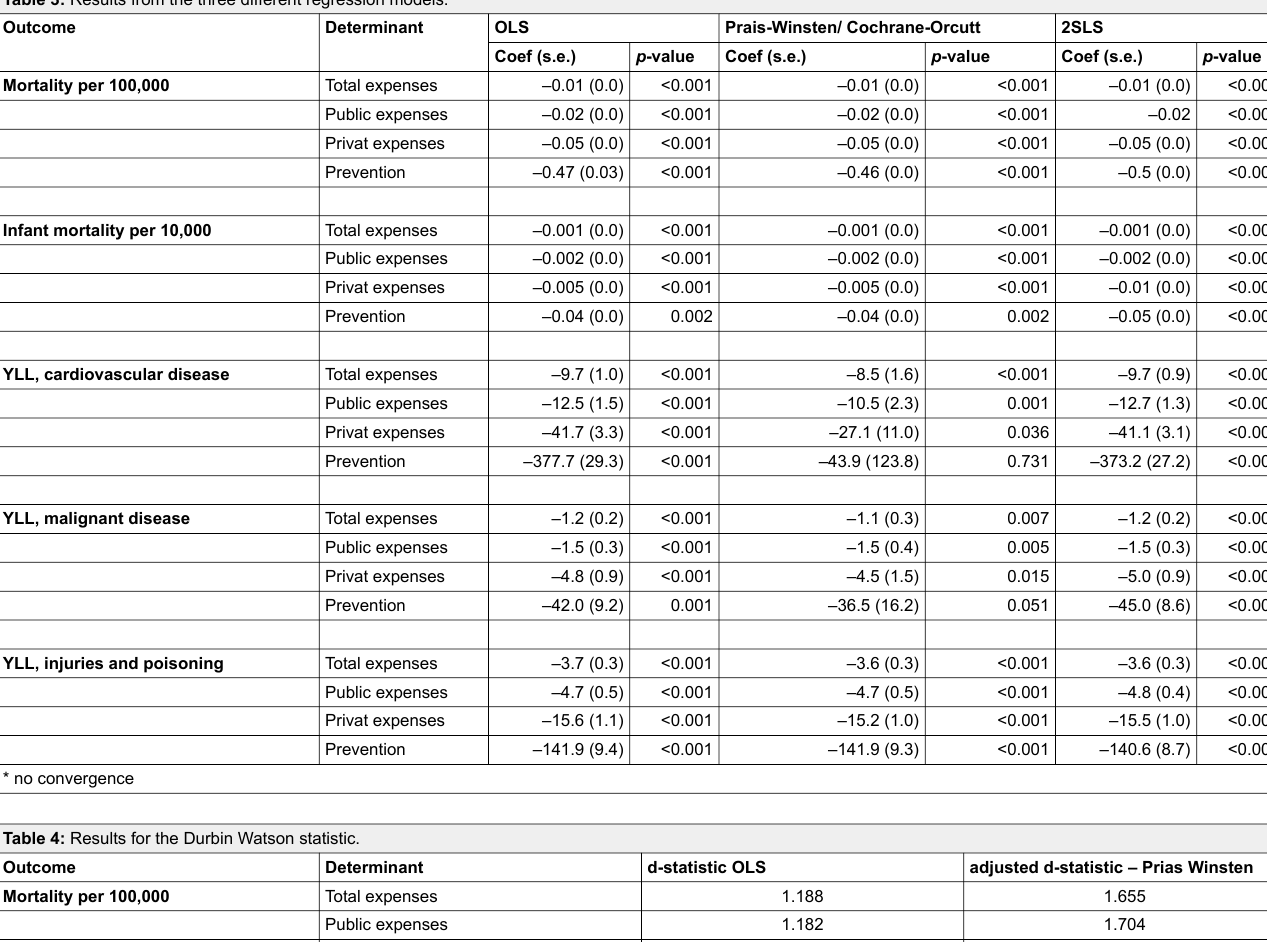
Table 3: Results from the three different regression models.